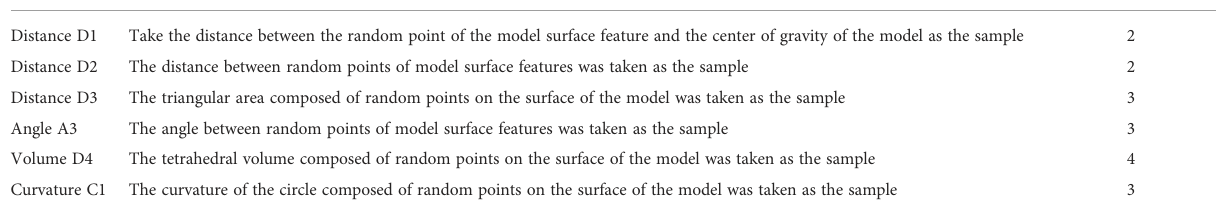
TABLE 1 Shape-distribution function